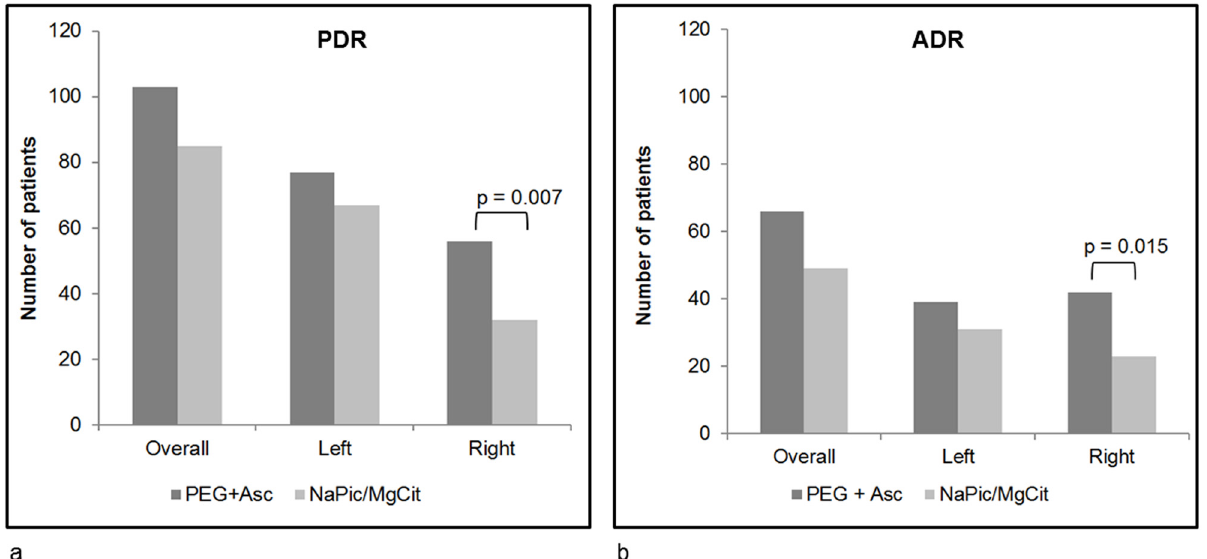
Fig 2. The number of patients with at least one polyp (a) or adenoma (b), overall and on the left and right sides of the colon (ITT population). The left side includes the rectum, sigmoid colon, descending colon, left half of the transverse colon, and the right side includes the right half of the transverse colon, the ascending colon, and cecum. Adenomas were confirmed by a pathologist. Statistical significance was determined by two-sided Chi-square tests. Data are missing for one patient in the PEG+Asc treatment group. ADR, adenoma detection rate; NaPic/MgCit, sodium picosulfate/magnesium citrate; PDR, polyp detection rate; PEG+Asc, polyethylene glycol plus ascorbate.